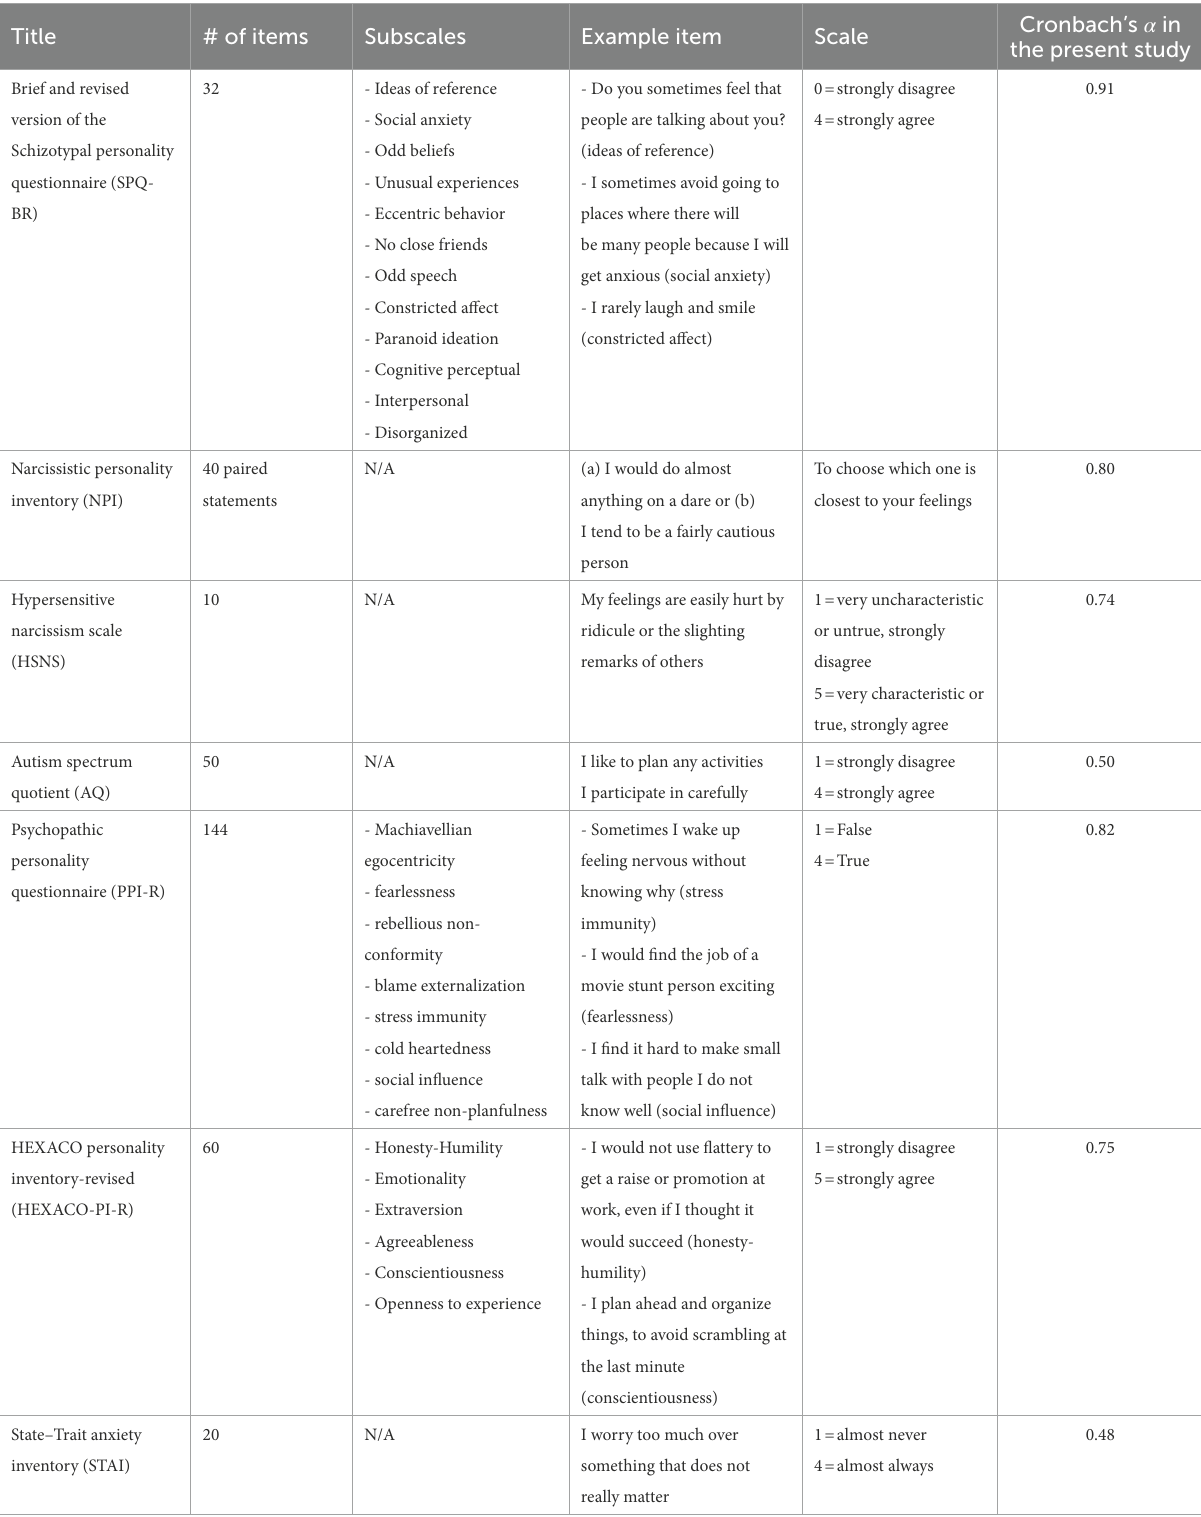
TABLE 1 Overview of measures and scales used in this